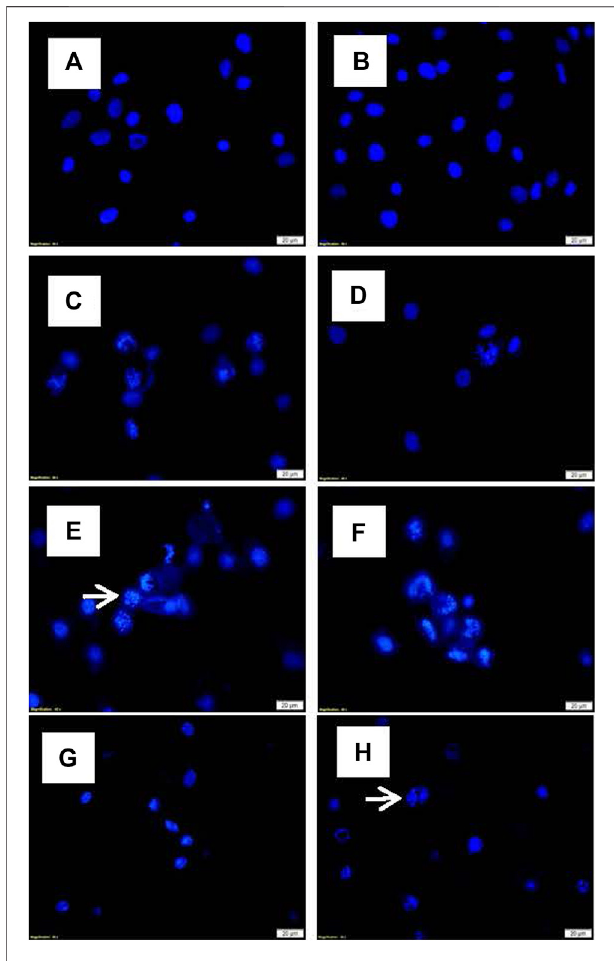
FIGURE 3 | Nuclei morphology of A549 cells after exposure to different doses of TO and TO-PDT under a fl uorescent microscope (x400 Magni fi cation). (A) Untreated control, (B) Irradiation only, (C) 5 µlTO, (D) 10 µl TO, (E) 15 µl TO, (F) 5 µl TO-PDT, (G) 10 µl TO-PDT, (H) 15 µl TO-PDT. Scale bar 20 µm. White arrows indicate examples of abnormal cell